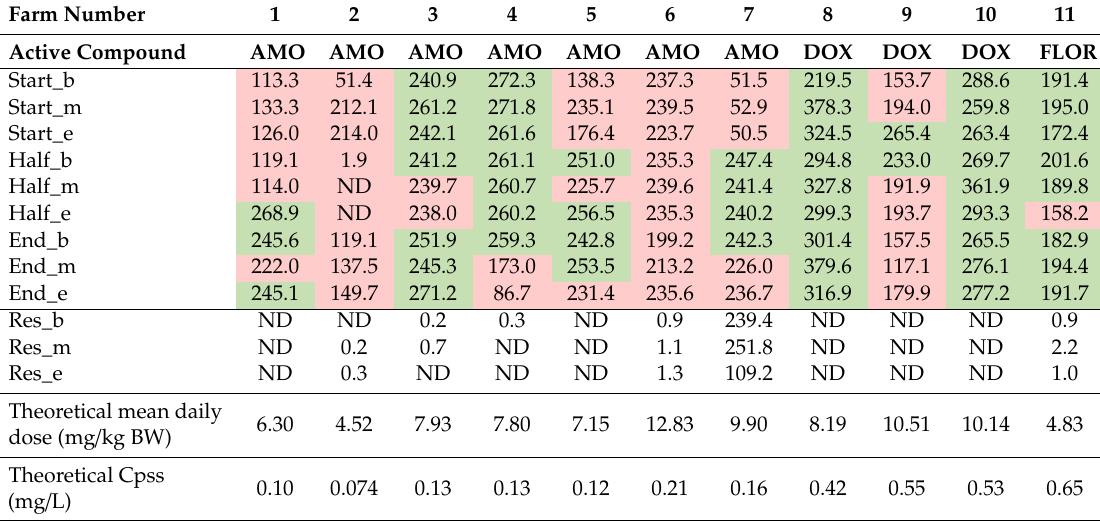
Table 1. Mean concentrations of amoxicillin (AMO), doxycycline (DOX), and florfenicol (FLOR) in the medicated feed samples (duplicate measurements), presented as µ g / g. The samples were collected at the start of treatment period and were sampled at the beginning (Start_b), middle (Start_m), and end (Start_e) of the feed line, as well as halfway through the treatment period (Half, at the beginning (Half_b), middle (Half_m), and end (Half_e), of the feeding line), on the last day of treatment (End, at the beginning (End_b), middle (End_m), and end (End_e), of the feeding line), and 2 days after the end of the treatment to measure the residues (Res) at the beginning (Res_b), middle (Res_m), and end of the feed line (Res_e). Values shown in green are within the therapeutic concentration range for that active therapeutic concentration range. Values below the detection limit are presented as ND (not detected). The theoretical mean daily dose of each antimicrobial drug during treatment (mg / kg BW) is presented at the bottom, and is based on the average bodyweight (BW) and average daily feed intake per farm. The corresponding theoretical plasma concentration at steady state (Cpss, mg / L) is also